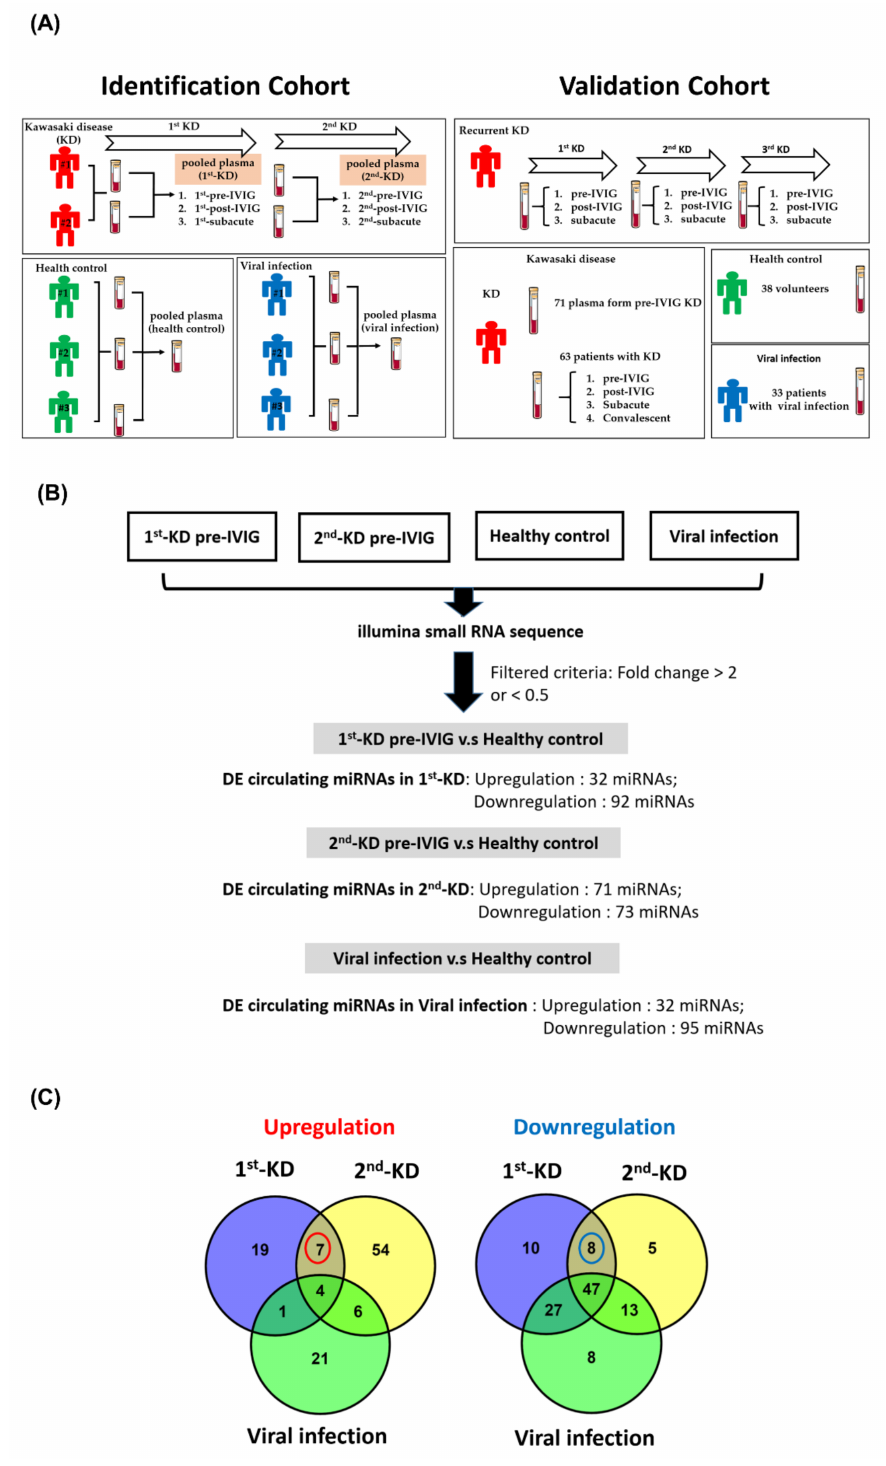
Figure 1. Identification of differentially expressed circulating microRNA (miRNA) in plasma